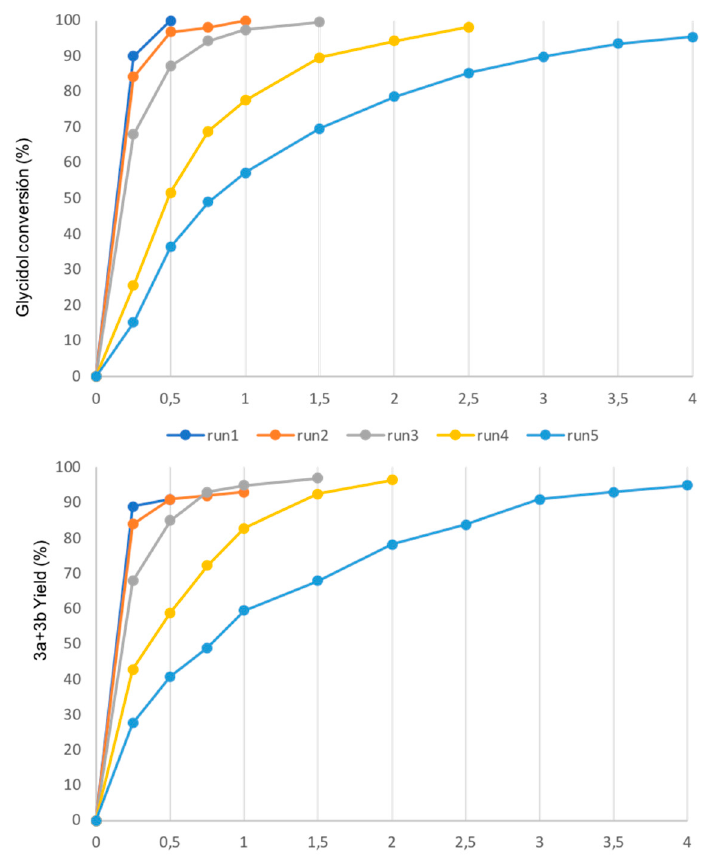
Figure 4. Recoverability of K10-Al (5% mol) in the reaction of glycidol ( 1 ) with methanol ( 2a ).